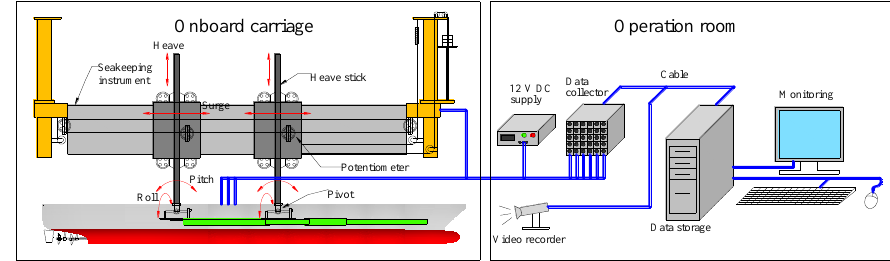
Figure 10. Sketch of tank measurement system.